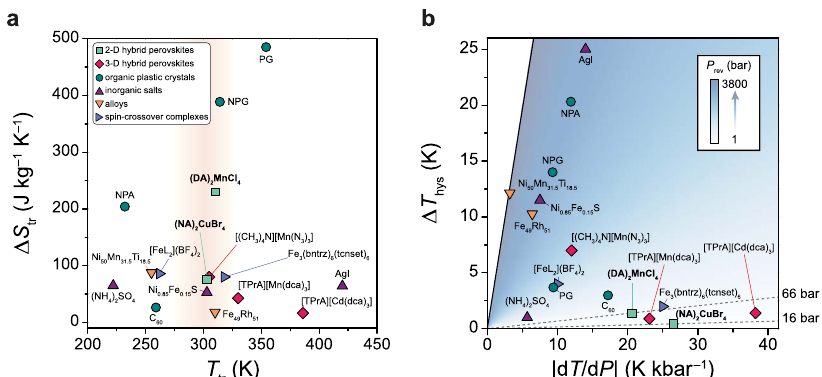
Fig. 7 Properties of representative barocaloric materials. a Comparison of the phase-change entropy, Δ S tr , and temperature, T tr , for different classes of barocaloric materials. Note that Δ S tr and T tr are shown for endothermic transitions, and Δ S tr represents the maximum isothermal entropy change that could be driven by the pressure-induced phase transition. b Comparison of thermal hysteresis, Δ T hys , and barocaloric coef fi cient, d T /d P , for leading barocaloric materials, with d T /d P values corresponding to exothermic transitions for materials that exhibit conventional barocaloric effects and endothermic transitions for materials that exhibit inverse barocaloric effects. The minimum pressure required to achieve a reversible entropy change, P rev , is calculated as P rev = Δ T hys /|d T /d P | and indicated by shading from blue (high P rev ) to white (low P rev ). A comprehensive tabulation of barocaloric properties, including reversible and irreversible Δ S it values, is provided in Supplementary Tables 5 and 6.